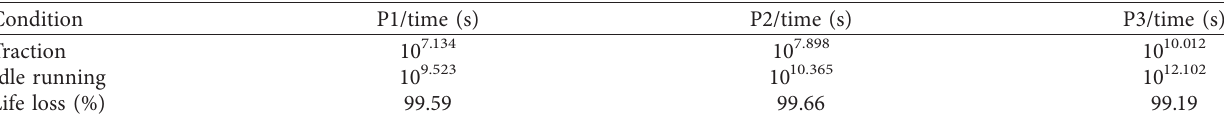
Figure 12: S-N curve of 16MnR steel (95% reliability). Table 3: Comparison of fatigue life under the traction condition and idle running